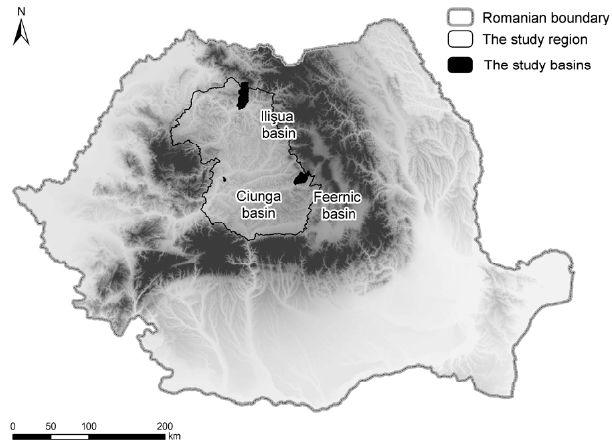
Fig. 1. The location of the study 3 Figure 1. The location of the study areas.